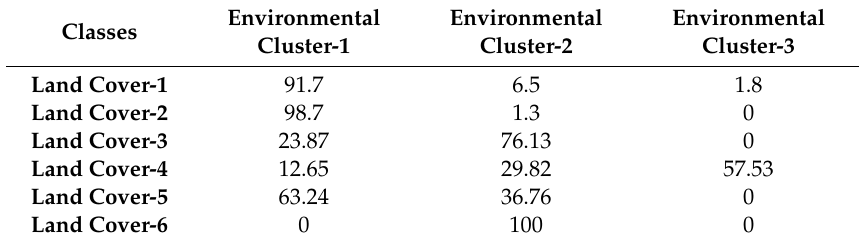
Table 5. The overlap percentages between the environmental cluster and Land Use Land Cover classes.